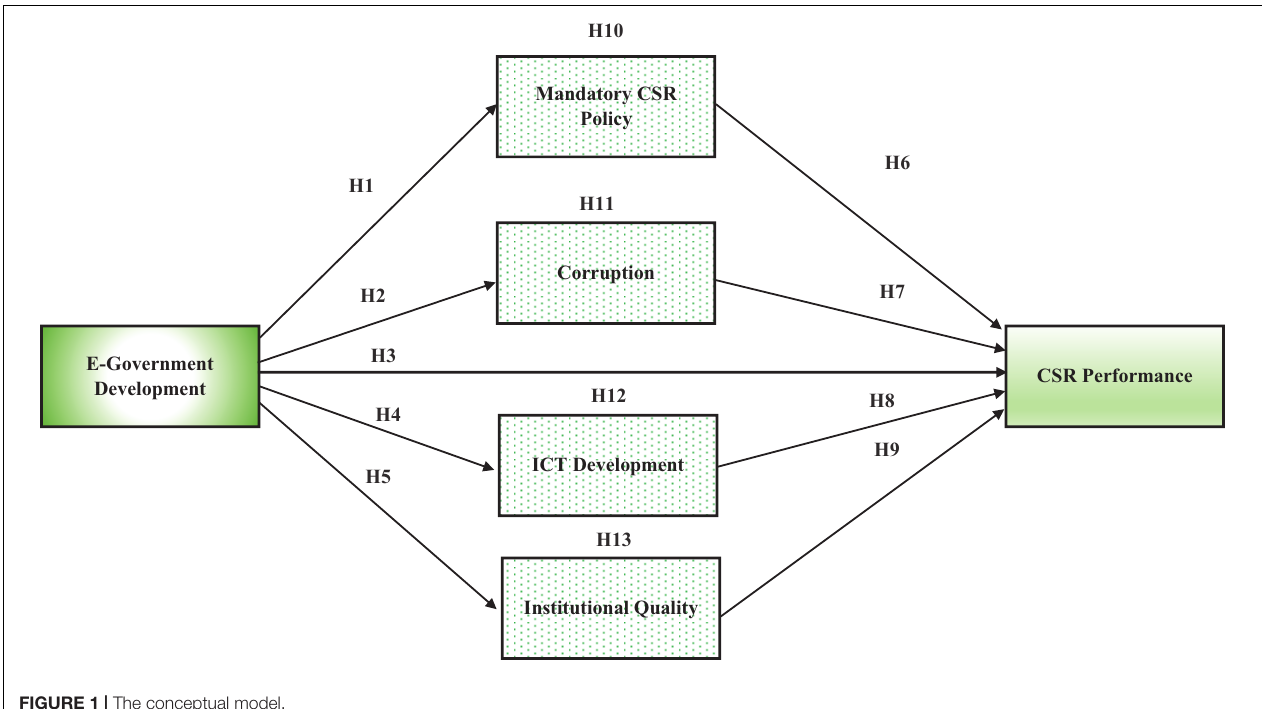
FIGURE 1 | The conceptual model.